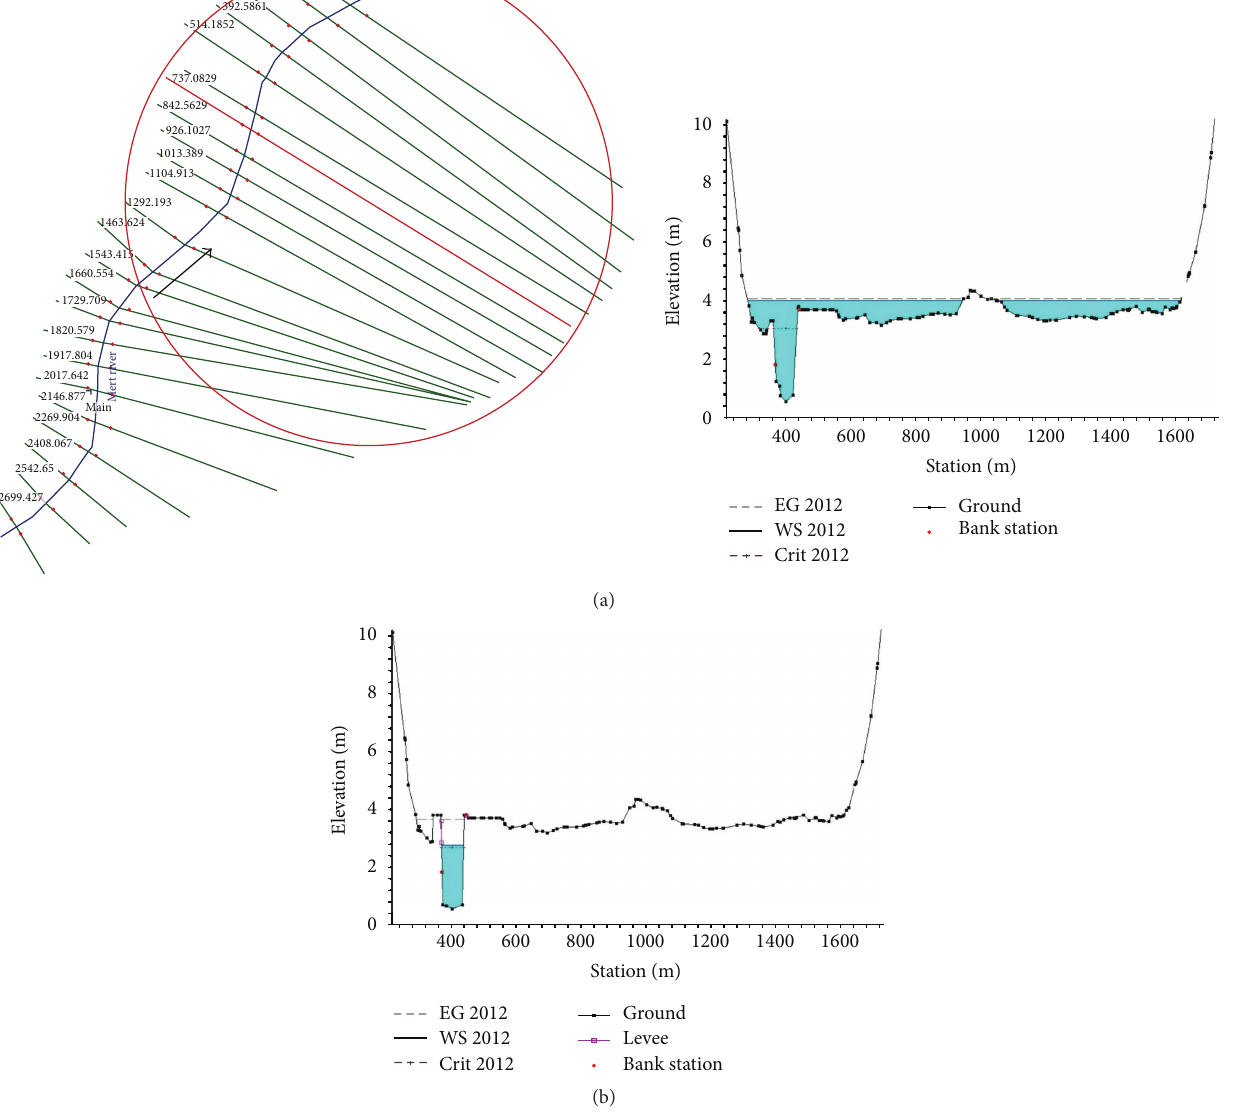
Figure 7: The analyzed cross sections of Mert River and flooded area in the case of 2012 flood: (a) flood effect for the selected section; (b) prevention of flood by adding levee and regulation of river